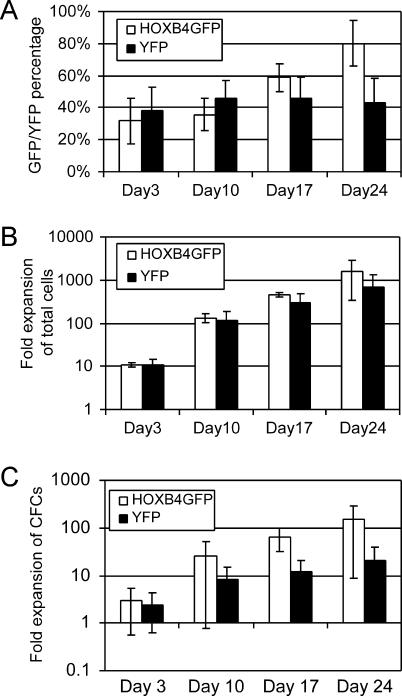
Efficient HOXB4-Mediated Ex Vivo Expansion of
M. nemestrina CD34
+ Cells
The mean and standard deviation of four independent experiments are shown. HOXB4GFP- or YFP (control)–transduced
M. nemestrina bone marrow CD34
+ cells were kept in liquid culture for 4 wk. Culture media were changed regularly to keep cells at optimum densities.
(A) Percentage of HOXB4GFP
+ or YFP
+ cells.
(B) Fold expansion of total nucleated cells.(C) Fold expansion of CFCs.